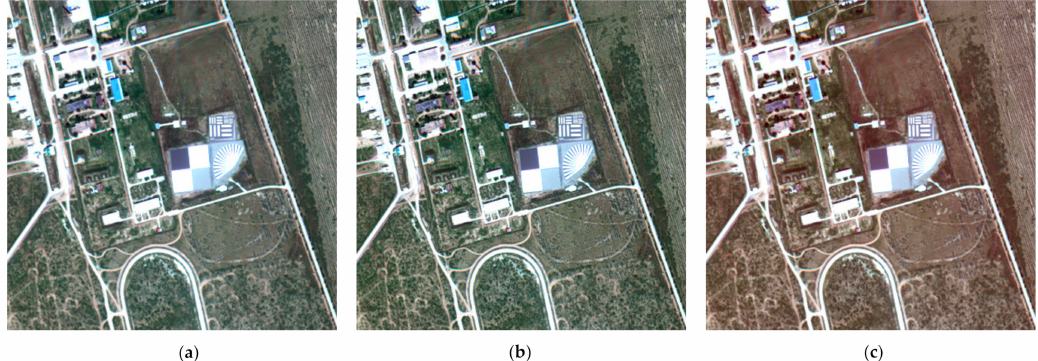
Figure 16. Images of Baotou on 26 August 2020. ( a ) Original image; ( b ) corrected image after Syn-AC; ( c ) corrected image after FLAASH. The retrieved AOD at 550 nm and retrieved CWV are 0.338 and 1.42 g/cm 2 , respectively.